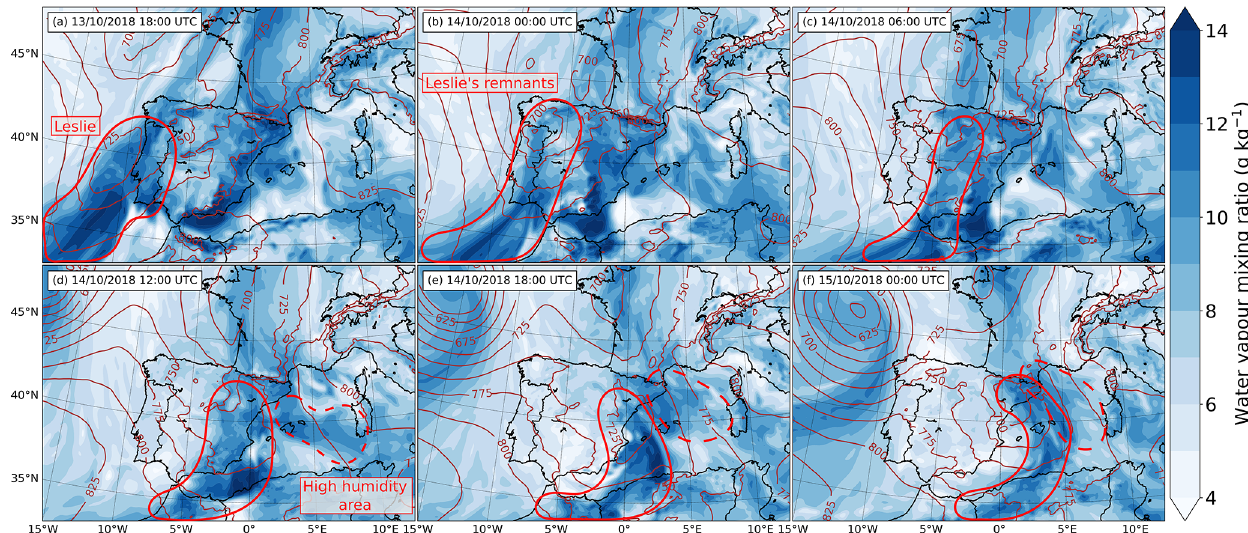
Figure 4. ARPEGE analyses of water vapour mixing ratio and geopotential height (in gpm) at 925hPa on 13 October 2018 at (a) 18:00UTC; on 14 October 2018 at (b) 00:00UTC, (c) 06:00UTC, (d) 12:00UTC and (e) 18:00UTC; and (f) on 15 October 2018 at 00:00UTC. The approximate location of moist air masses carried by Leslie (solid red line) or found over the Mediterranean Sea (dashed red line) is